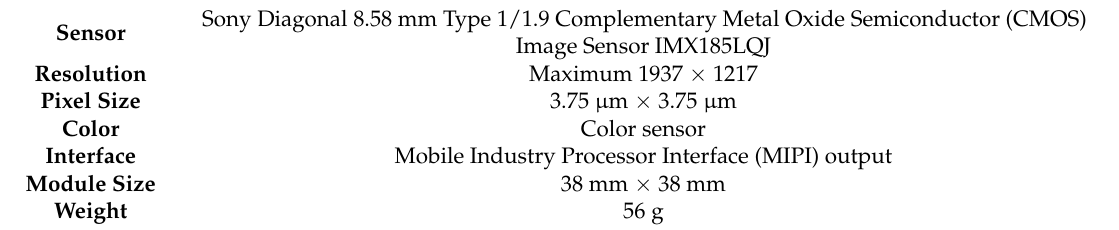
Table 1. IMX 185 Table 1. IMX 185 specification. Table 1. IMX 185 specification.